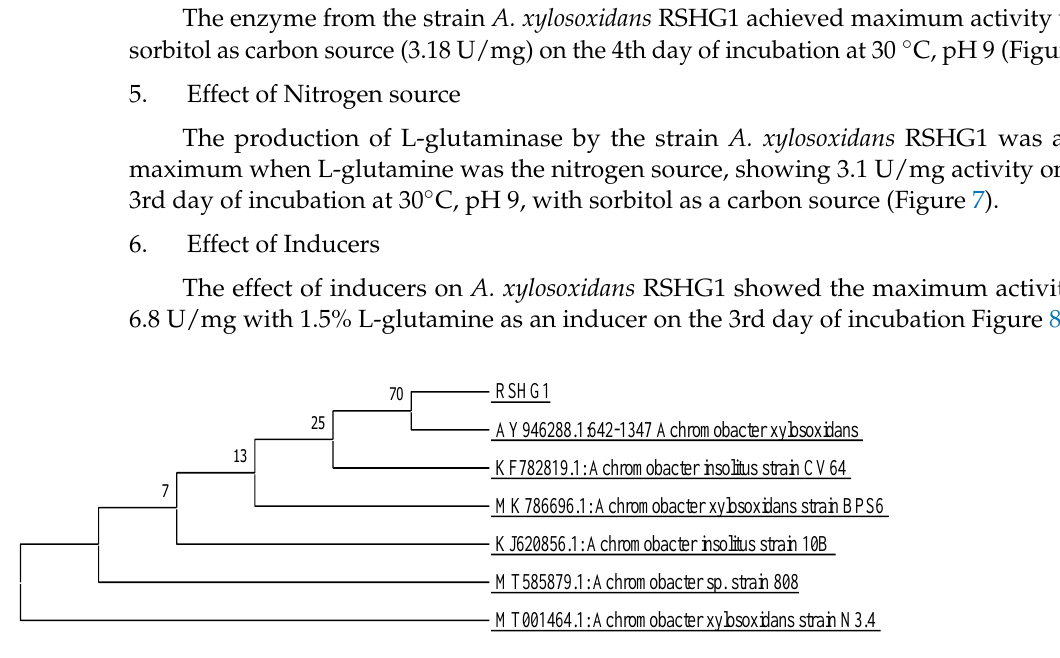
Figure 2. Phylogenetic tree for the bacterial isolate RSHG1 showing relatedness with other organisms. Catalysts 2021 , 11 , x FOR PEER REVIEW